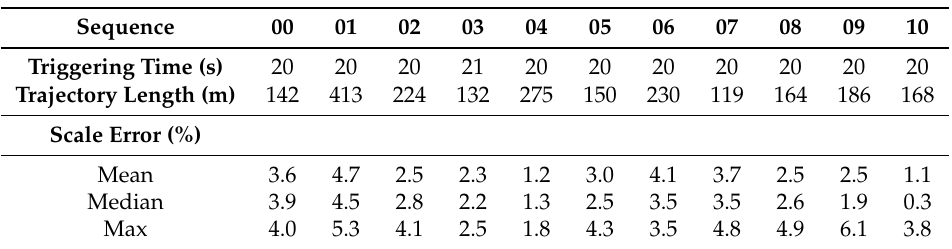
Table 1. Scale initialization of Global Navigation Satellite System–visual-ORB–simultaneous localization and mapping